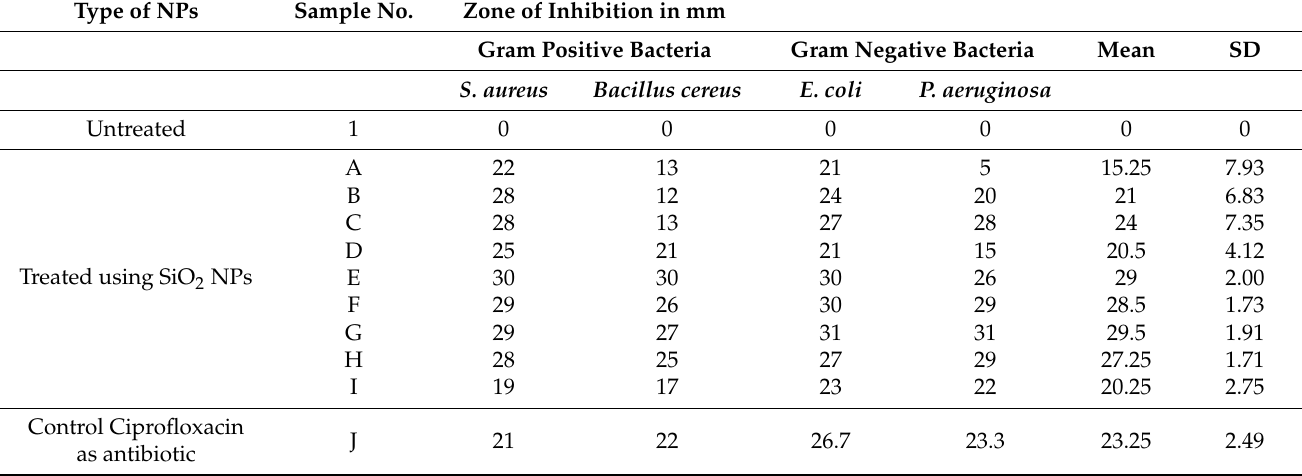
Figure 5. EDX spectrum of ( A ) SEM image ( B ) cotton/lycra (95.5/5.5%) fabric of 15 pick/cm, ( C ) cotton/lycra (90.8/9.2%) fabric of 19 pick/cm, and ( D ) cotton (100%) fabric of 22 pick/cm treated with SiO 2 NPs, and EDX mapping of cotton/lycra (90.8/9.2%) fabric of 19 pick/cm corresponding to ( E ) carbon, ( F ) oxygen, ( G ) silicon, and ( H ) overlap at 20 µ m bar scale. Table 3. Antibacterial Activity of the Blank and SiO 2 NP/Cotton/Lycra Composites. Cotton (100%) 15 pick/cm ( A ), cotton (100%) 19 pick/cm ( B ), Cotton (100%) 22 pick/cm ( C ), cotton/lycra (90.8/9.2%) 15 pick/cm ( D ), cotton/lycra (90.8/9.2%) 19 pick/cm ( E ), cotton/lycra (90.8/9.2%) 22 pick/cm ( F ), cotton/lycra (94.5/5.5%) 19 pick/cm ( G ), cotton/lycra (94.5/5.5%) 22 pick/cm ( H ), cotton/lycra (94.5/5.5%) 15 pick/cm ( I ). Type of